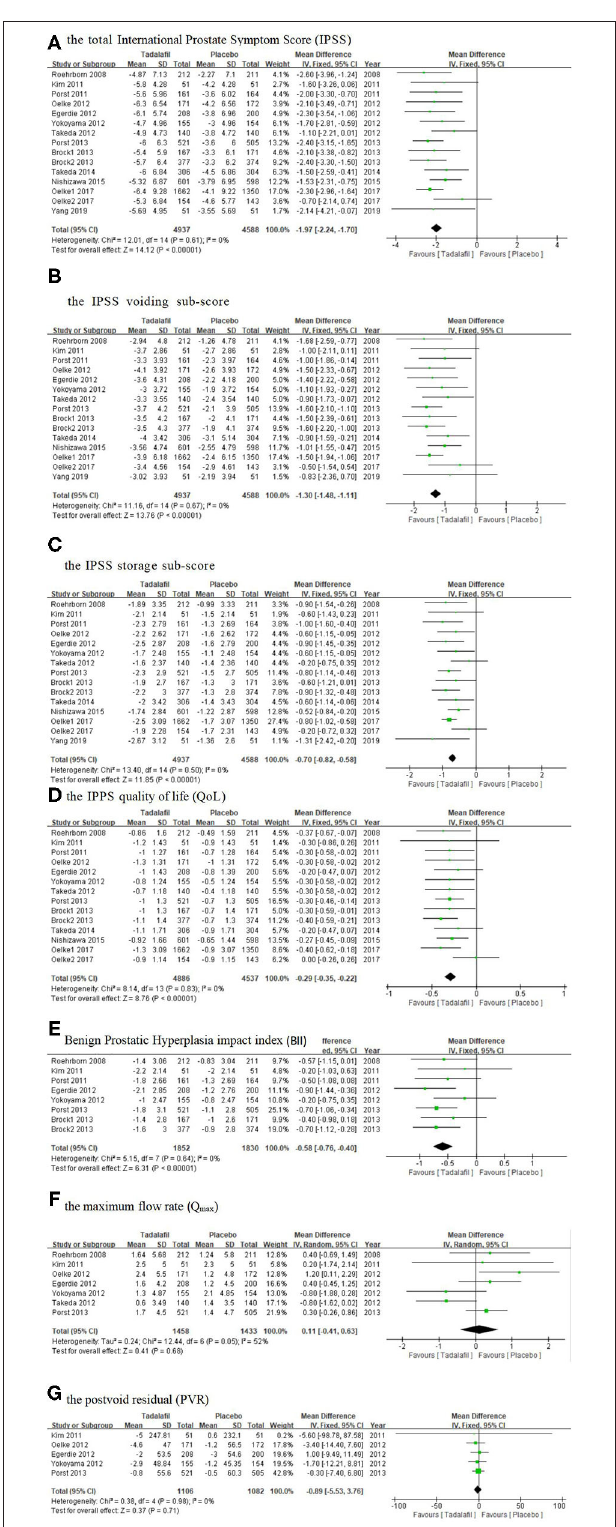
FIGURE 3 | Forest plot of (A) the total IPSS; (B) the IPSS voiding subscore; (C) the IPSS storage subscore; (D) the IPSS QoL; (E) BII; (F) Q max ; and (G) PVR. IPSS, International Prostate Symptom Score; PVR, postvoid residual; QoL, quality of